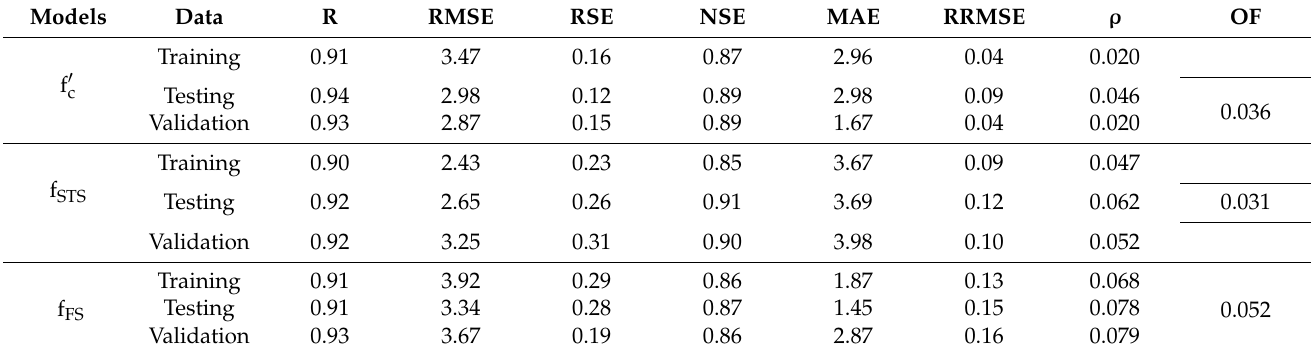
Table 4. Inferential statistics for the training, testing, and validation datasets.